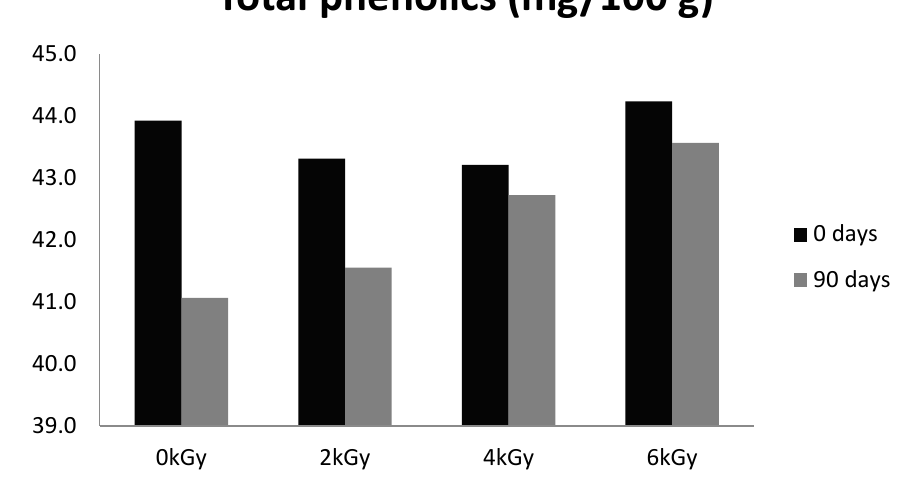
Figure 4. Effect of gamma radiation on total phenolic contents in hot peppers during three months’ storage.